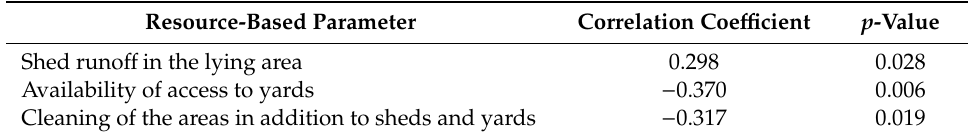
Table 4. Spearman’s Rank Correlation coe ffi cients with p -values for hair cortisol concentration (pg / mg) with resource-based parameters.